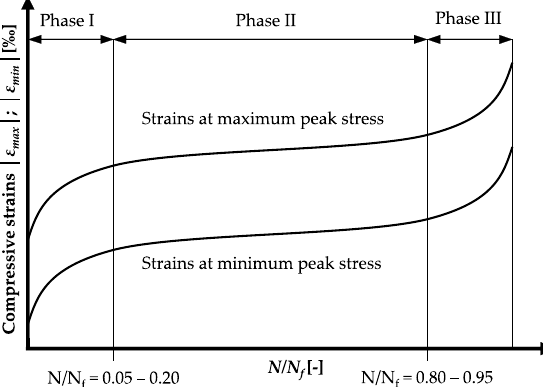
Figure 1. S-shaped s train developments during fatigue loading